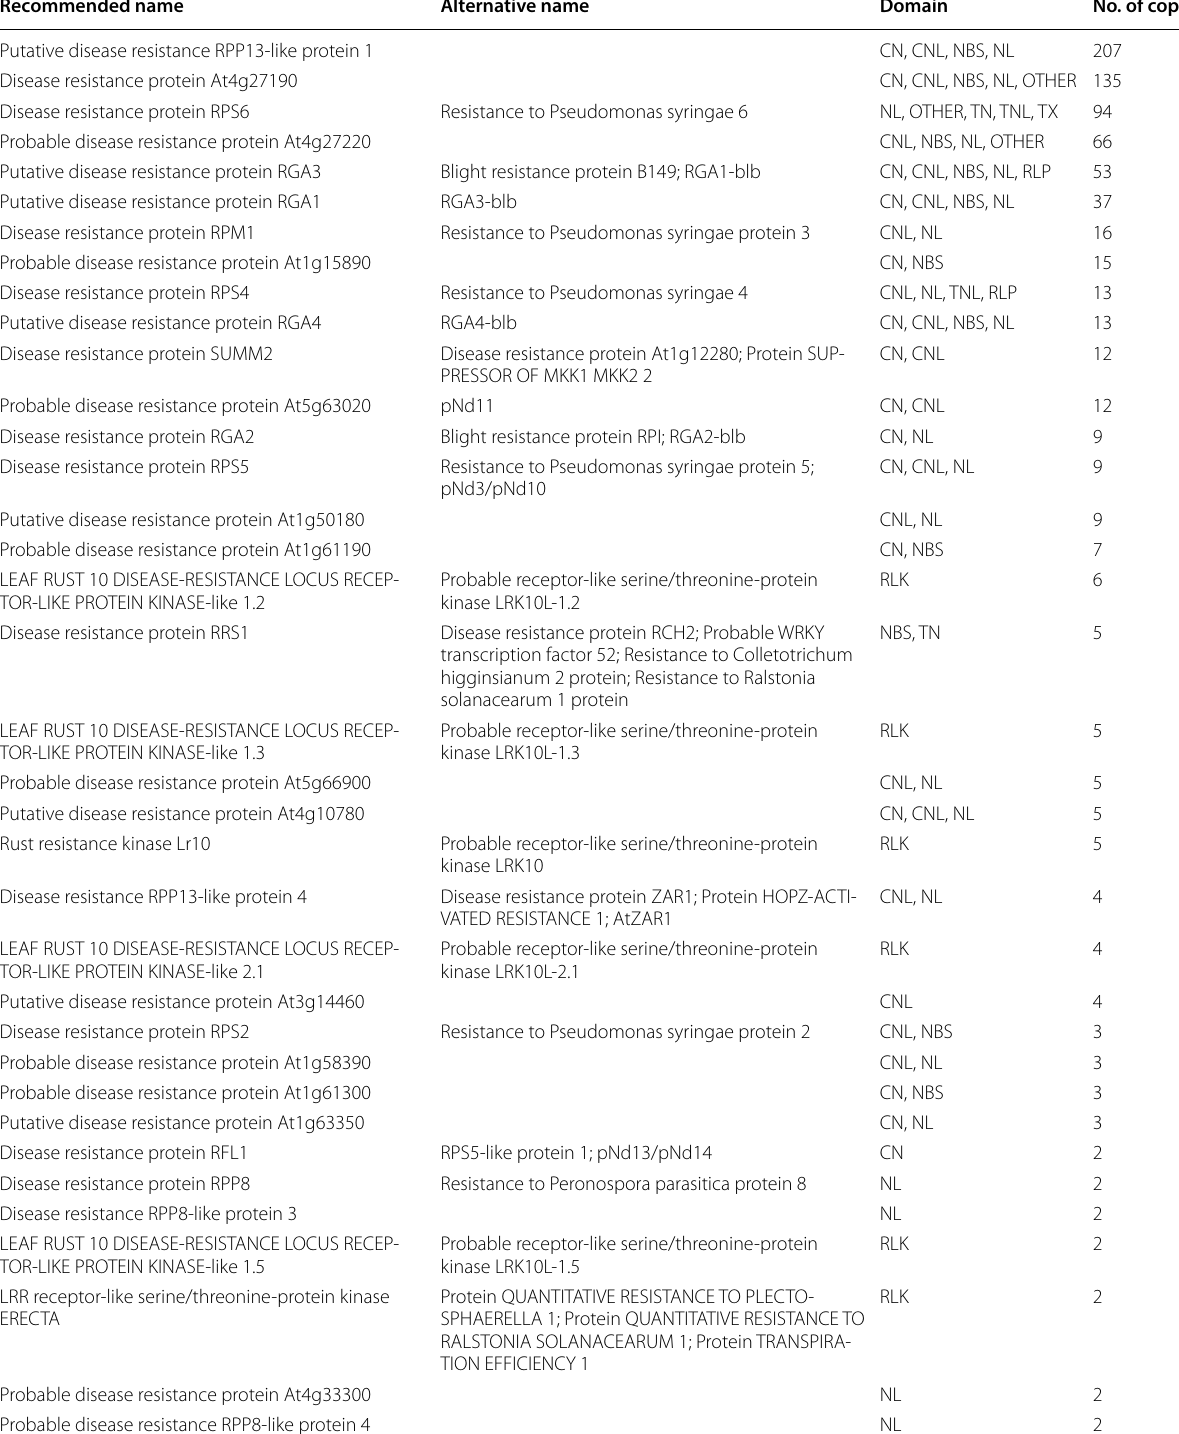
Table 2 Durian RGAs with homology to well-known resistance